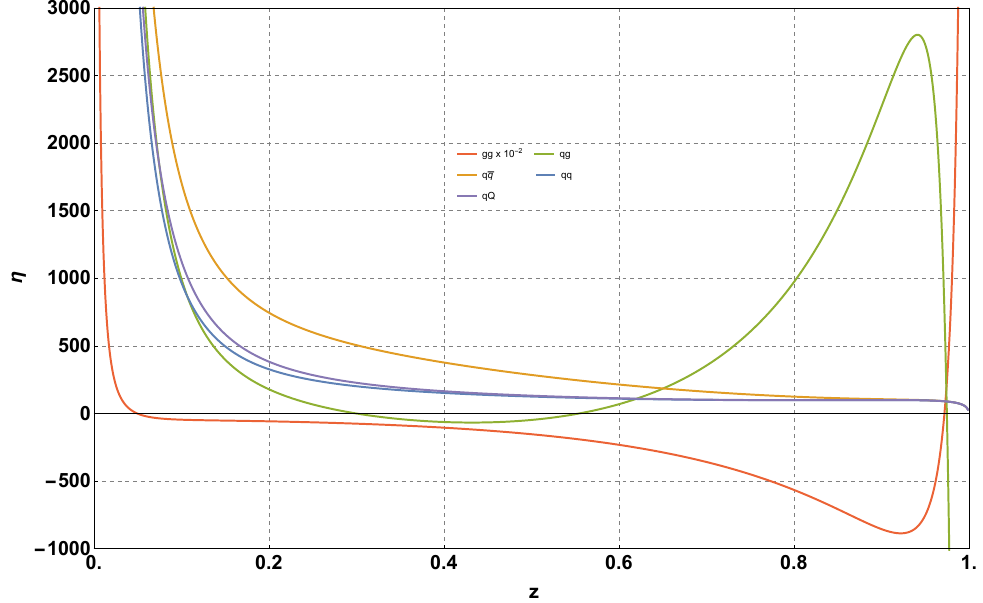
Figure 2 . The (cid:12)gure displays the regular N 3 LO coe(cid:14)cient function for the Higgs boson production cross section for the gg (red), qg (green), q(cid:22) q (orange), qq(blue) and qQ(purple) initial state as a function of the parameter z. The gg coe(cid:14)cient function was rescaled uniformly by a factor of 10 (cid:0) 2